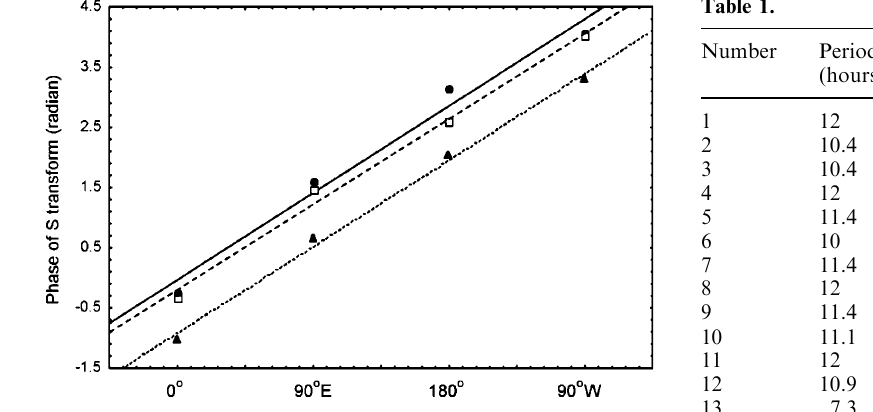
Fig. 3. The relative phases of significant intradiurnal oscillations versus longitude for the observational period June 19, 1995–June 30, 1995. Solid line 8.3 h oscillation, dashed line 9.5 h oscillation, dotted line 10.7 h